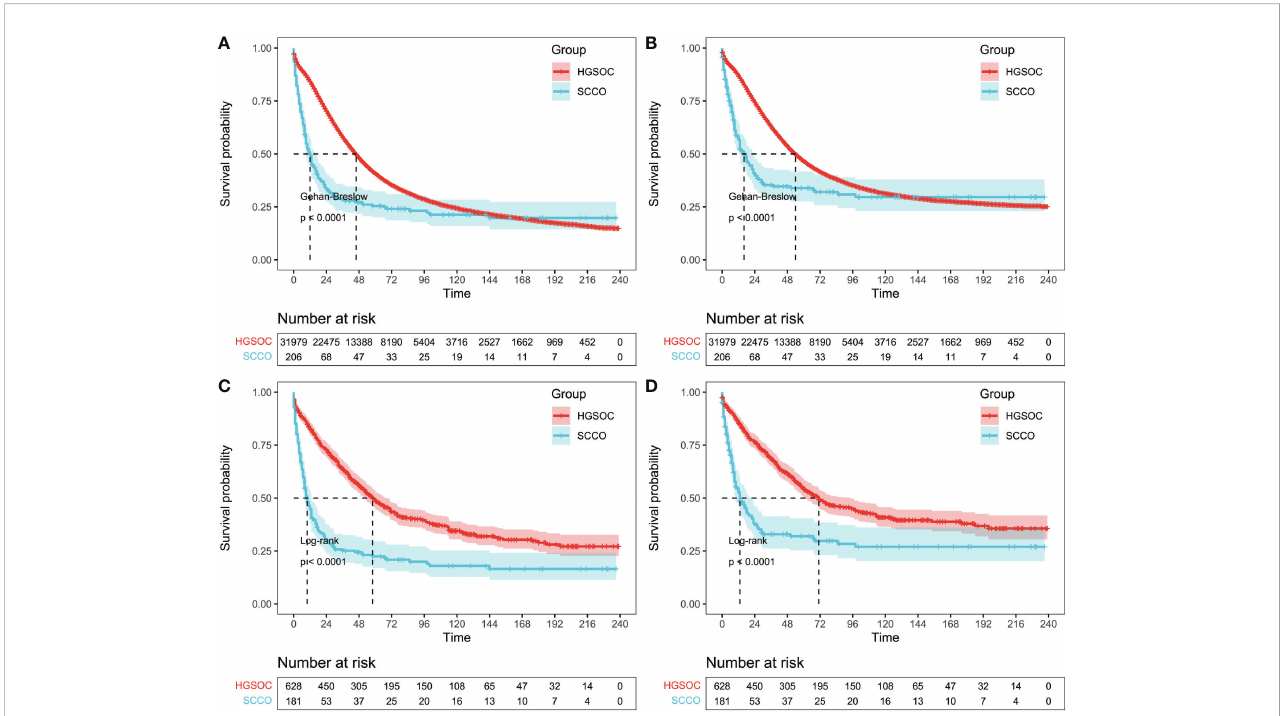
FIGURE 3 Survival outcomes before and after propensity-score matching. (A) Overall survival and (B) cancer-speci fi c survival based on patients with HGSOC or SCCO before propensity-score matching. Gehan-Breslow tests were used to generate P-values. (C) Overall survival and (D) cancer-speci fi c survival based on patients with HGSOC or SCCO after propensity-score matching. Log-rank tests were used to generate P-values. HGSOC, high grade serous ovarian cancer; SCCO, Small cell carcinoma of the ovary.